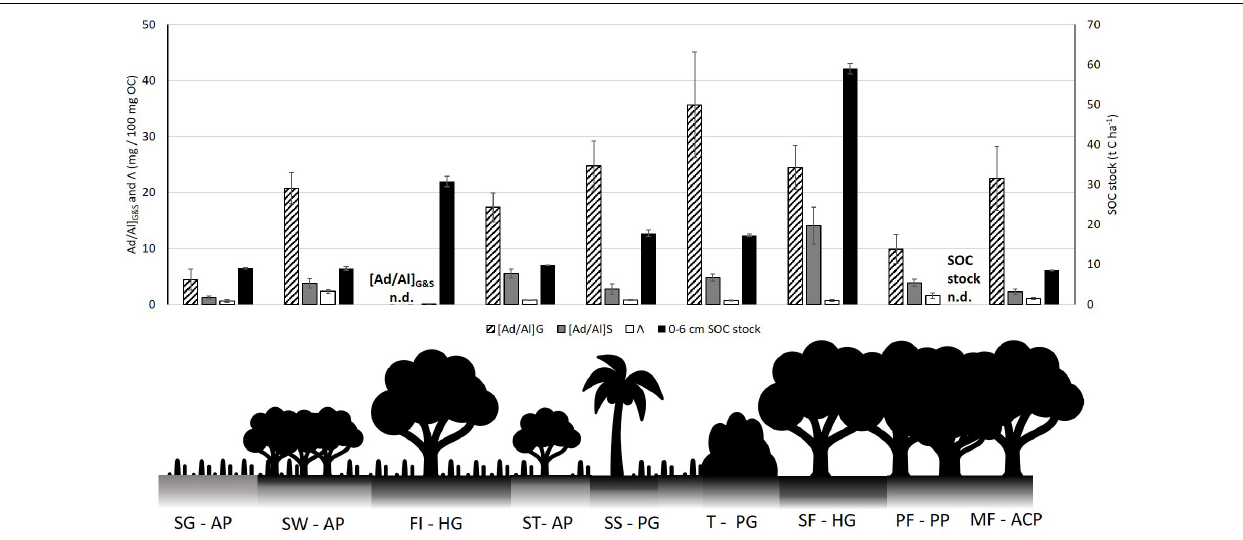
FIGURE 8 | Comparison of lignin phenol degradation ratios [Ad/Al] G & S and (cid:51) against surface 0–6 cm SOC stocks along the study transect, illustrated by a schematic of vegetation types. Forest Island [Ad/Al] G & S and Pisoplinthic Forest SOC stock not determined (n.d.) SG AP, Savannah Grassland Albic Plinthosol; SW AP, Savannah Woodland Albic Plinthosol; FI HG, Forest Island Humic Gleysol; ST AP, Savannah Tree Albic Plinthosol; SS PG, Savannah Swamp Plinthic Gleysol; T PG, Transition zone Plinthic Gleysol; SF HG, Swamp Forest Humic Gleysol; PF PP, Pisoplinthic Forest Pisoplinthic Plinthosol; MF ACP, Mixed Forest Acric Plinthosol.